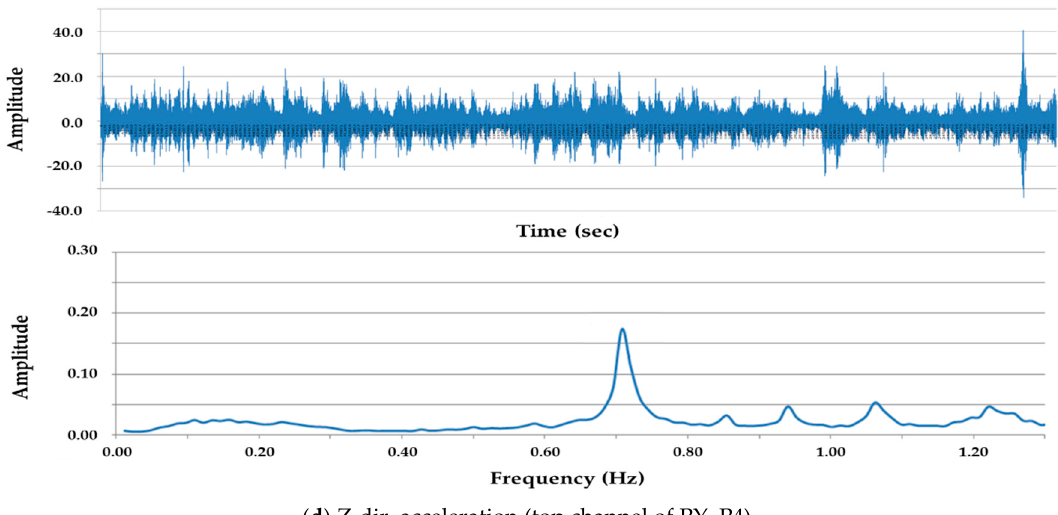
Figure 5. Time history and Fast Fourier Transform of ambient vibration test. ( a )–( d ) Acceleration data in corresponding positions.